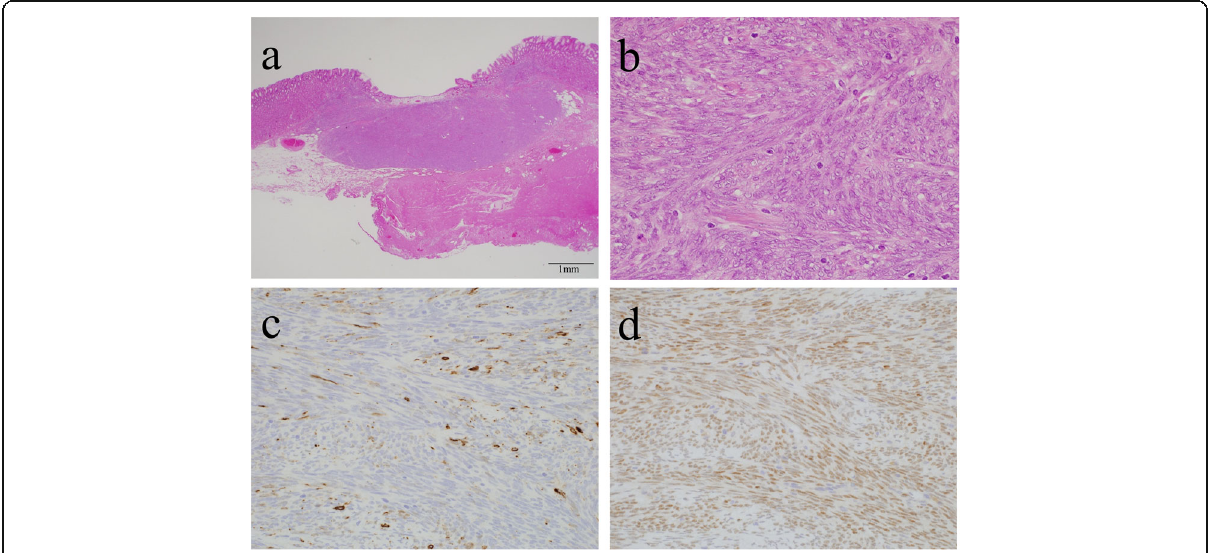
Fig. 3 Pathological findings of the tumor. A The maximum size of the mass was 6 mm, and it was mainly located in the submucosa (H&E staining, original magnification ×40). B It consisted of a dense proliferation of spindle-shaped cells (H&E staining, original magnification ×400). C AE1/AE3 was focally positive in tumor cells. D SS18-SSX fusion-specific antibody gave diffuse positive staining to tumor